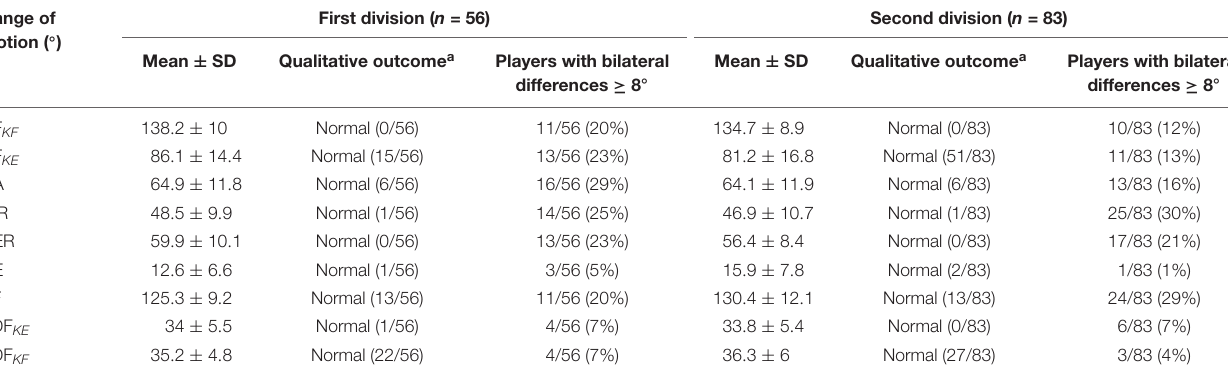
of the mean range of motion, in parentheses the number of players with a limited range of motion score according to previously published cut-off scores (see section “Statistical analysis”). 9 TABLE 4 | Descriptive values and number (percentage) of players with bilateral differences ≥ 8 ◦ for hip (flexion, extension, abduction, internal and external rotation), knee (flexion), and ankle (dorsal-flexion with knee flexed and extended) ranges of motion separately by competitive level. Range of First division ( n = 56) Second division ( n = 83) motion ( ◦ ) Mean ± SD Qualitative outcome a Players with bilateral Mean ± SD Qualitative outcome a Players with bilateral differences ≥ 8 ◦ differences ≥ 8